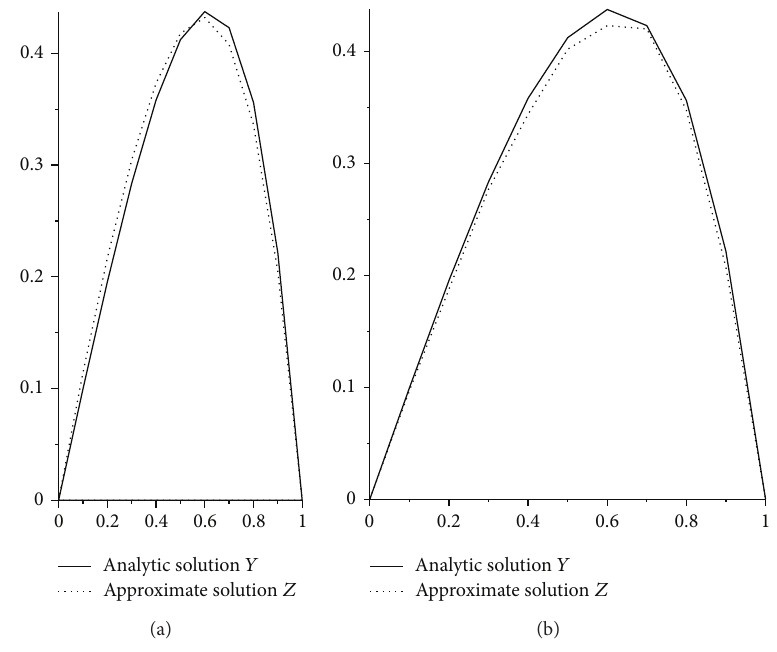
Figure 3: Comparison between analytic and approximating solutions.